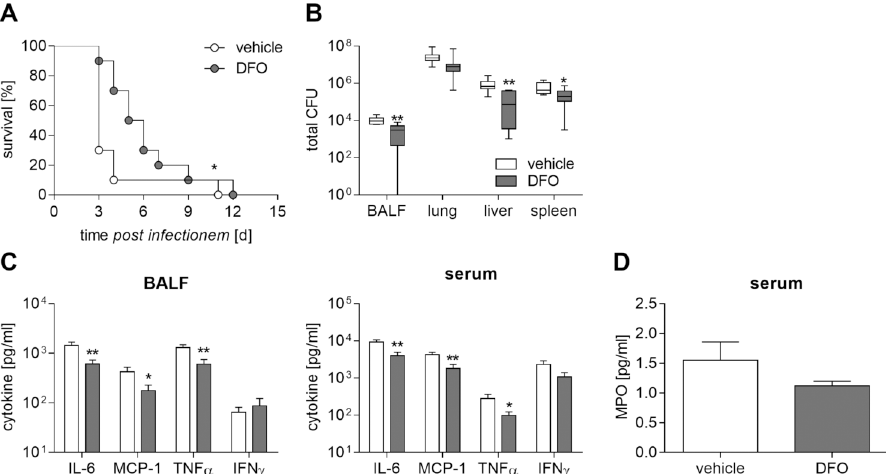
Fig 8. Limitation of iron availability ameliorates bacterial clearance and survival of infected mice. DFO (100 mg/ kg) or vehicle (D-PBS)-treated C57BL/6 mice were intranasally inoculated with B . pseudomallei at 500 CFU. (A) Cumulative survival rate between groups was compared using (Log-rank Kaplan-Meier test, (cid:3) p < 0.005 compared to vehicle-treated mice (2 independent experiments, n = 10)). (B) 48 hours after infection, the bacterial load (CFU) in BALF (n = 8) and organs (n = 10) was determined. Data from two experiments are expressed as box and whisker plots indicating minimum, maximum, quartiles and median. (C) Cytokine production (IL-6, MCP-1, TNF α , IFN γ ) in BALF (n = 8) and serum (n = 10), and (D) myeloperoxidase (MPO) levels in serum (n = 5) were measured 48 hours after infection. (C, D) Data from two experiments are presented as mean with SEM. (B-D) Statistical analyses were done using a Student’s t- test ( (cid:3) p < 0.05, (cid:3)(cid:3) p < 0.01).